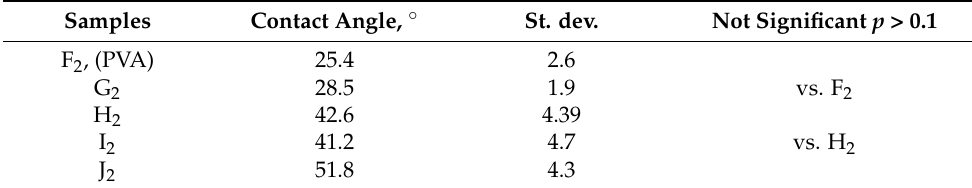
Table 5. Contact angles of serial